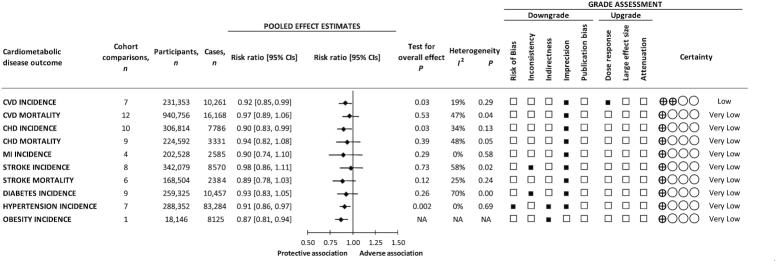
Summary and GRADE assessment of the pooled effect estimates of prospective cohort studies assessing the associations between dietary pulses with or without other legumes and cardiometabolic disease outcomes (the highest compared with the lowest level of intake) in participants free of the disease at baseline. Pooled risk estimate for each outcome is represented by the diamond. Data are expressed as weighted risk ratios with 95% CIs using the generic inverse-variance method modelled by random effects, or by fixed effects if data from <5 studies were available. Values of I2 ≥ 50% and P < 0.10 indicate substantial heterogeneity (10, 24). Values >1.0 indicate an adverse association. CHD, coronary heart disease; CVD, cardiovascular disease; GRADE, Grading of Recommendations Assessment, Development and Evaluation; MI, myocardial infarction; NA, not available.